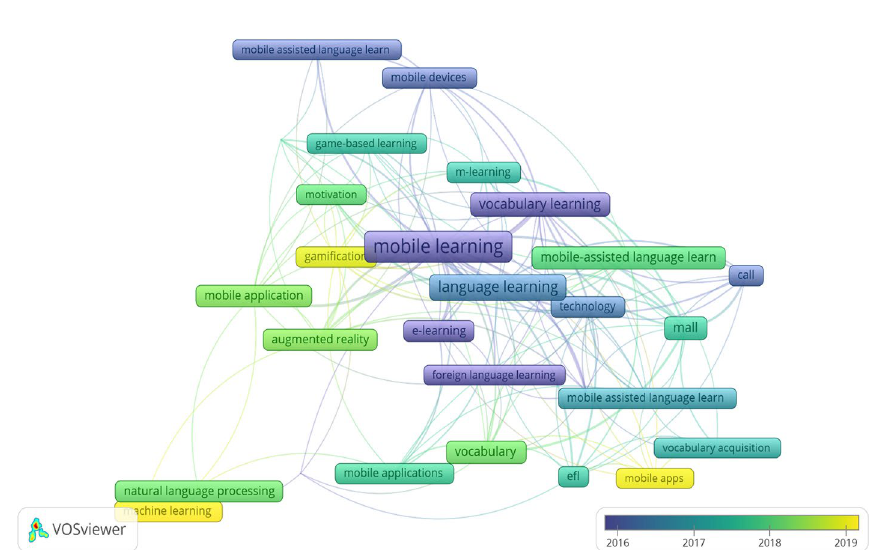
Fig. 3 The most frequent